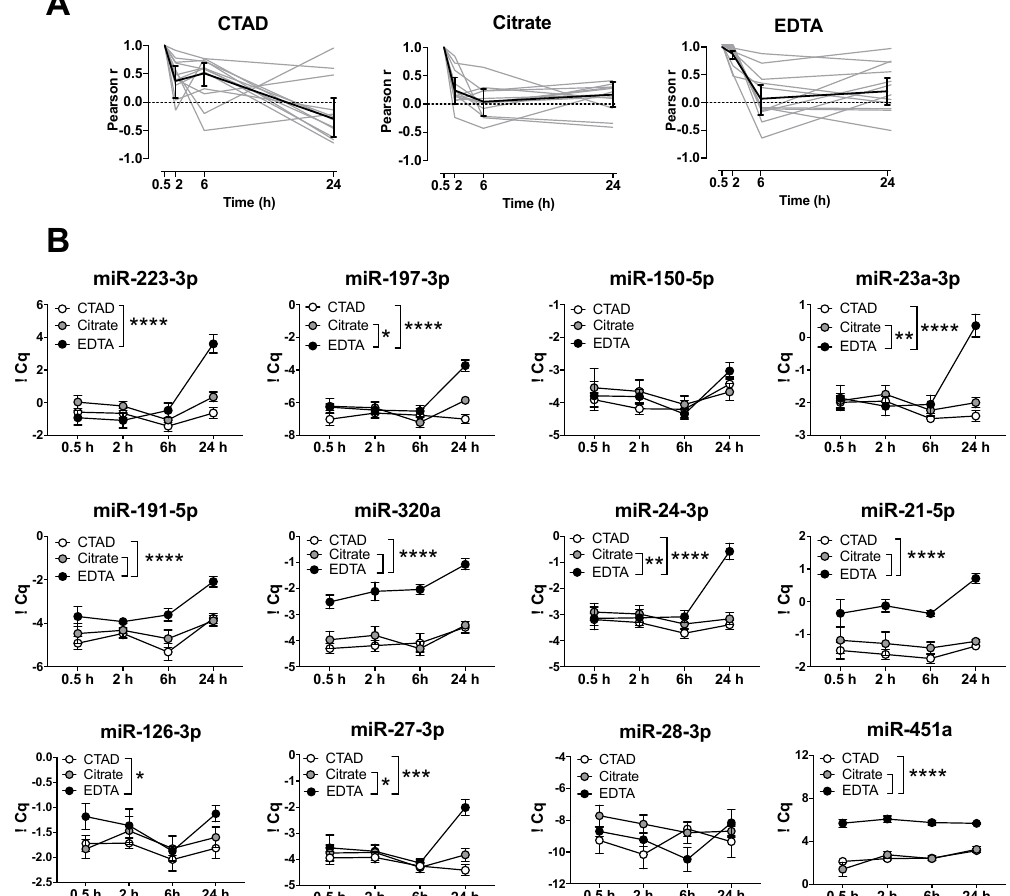
Figure4. Time-dependentdi ff erencesincirculatingmiRNAlevelsatroomtemperature(RT).( A )Pearson Figure 4. Time-dependent differences in circulating miRNA levels at room temperature (RT). ( A ) correlation coe ffi cients between timepoint 0.5 h and all other timepoints for all miRNAs after storage at Pearson correlation coefficients between timepoint 0.5 h and all other timepoints for all miRNAs after RT. ( B ) Blood from 6 healthy donors was anticoagulated with CTAD (white), citrate (gray), or EDTA (black) and stored at room temperature (RT) for 0.5 (immediate plasma preparation), 2, 6, or 24 h until plasma preparation. Data are represented as means with standard errors. Significant di ff erences were determined by two-way ANOVA using Sidak’s multiple comparison test and are depicted as * p < 0.05, ** p < 0.01, *** p < 0.001, and **** p <